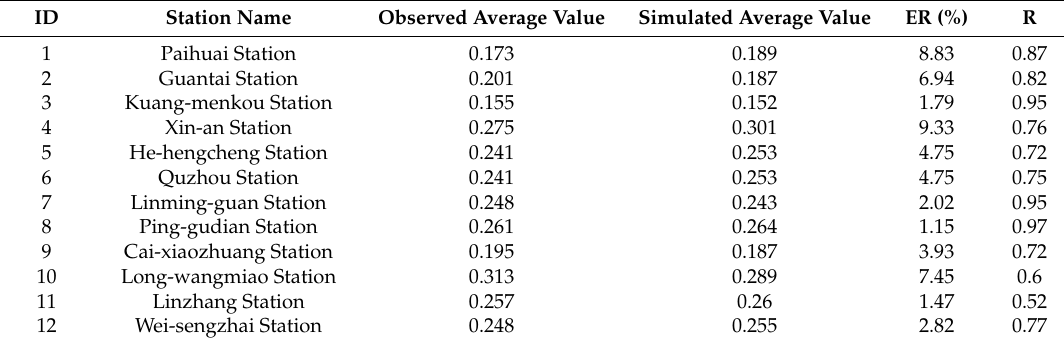
Table 6. Statistical results showing the consistency between observed and simulated values.